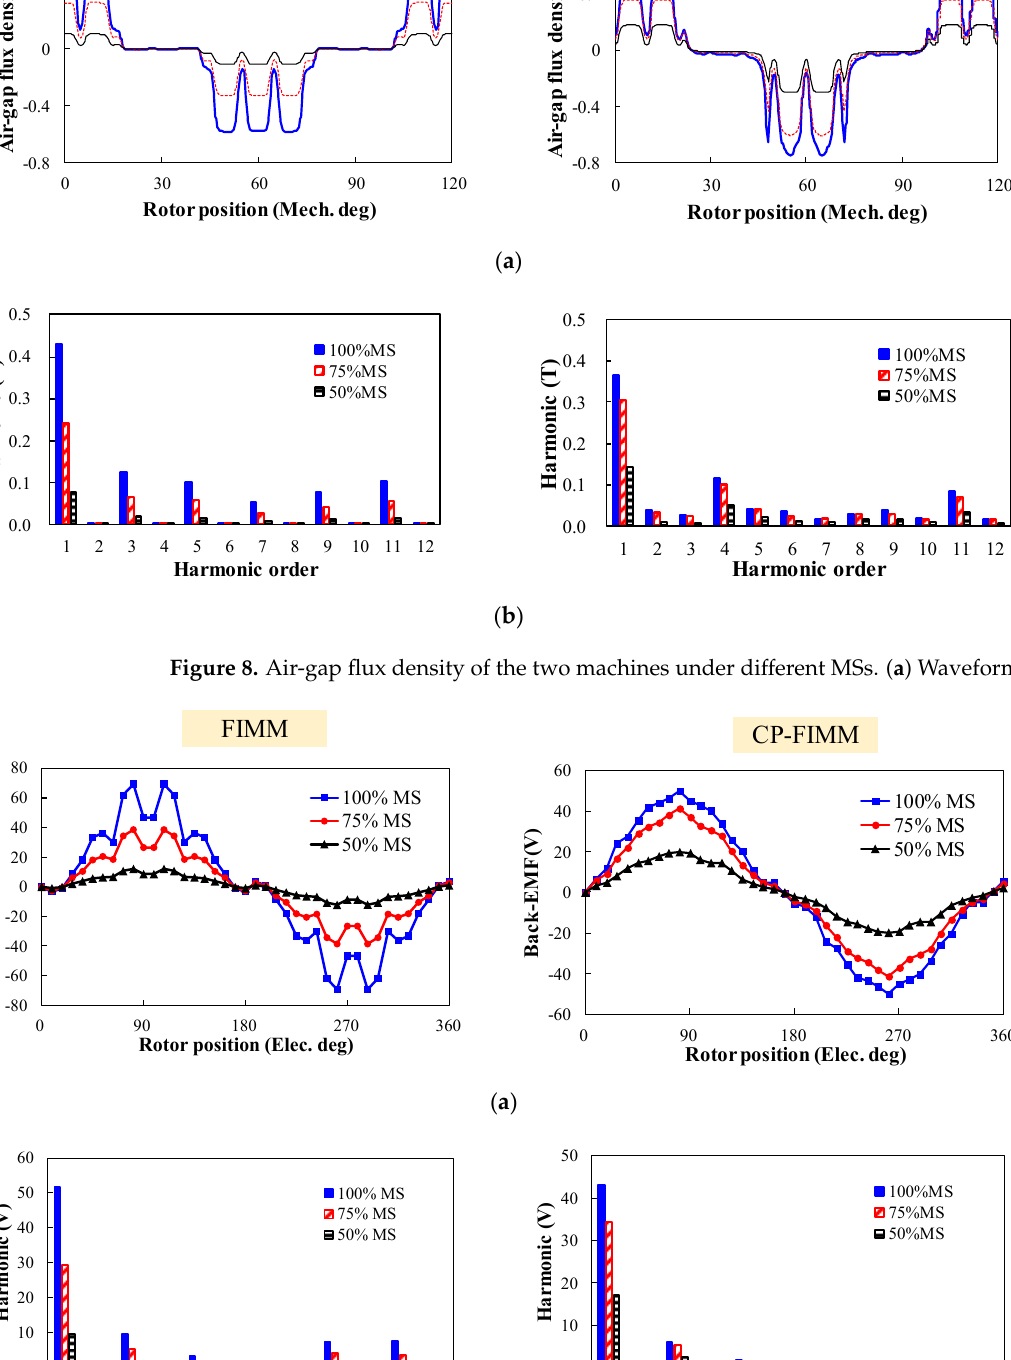
Figure 9. Back-EMF waveforms and harmonic analysis CP-FIMM and FIMM under different MSs. ( a ) Waveforms; ( b ) spectra.